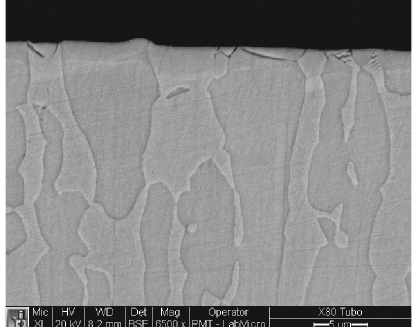
Figure 1. Nitrided layer obtain at 350 °C.